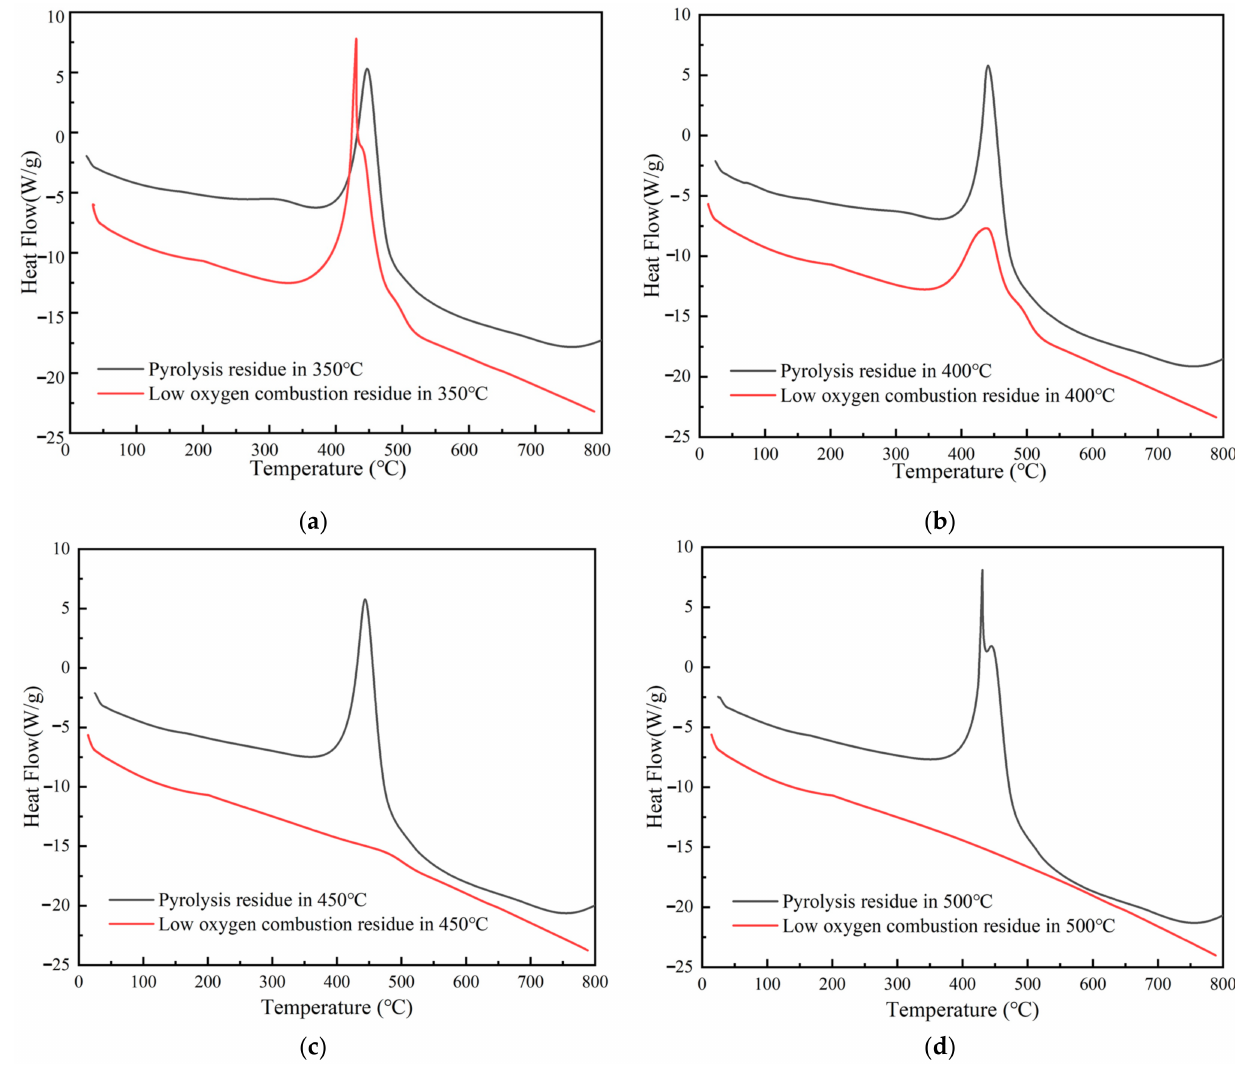
Figure 10. The DSC curve of residues’ oxidation. ( a ) The constant temperature is 350 ◦ C, ( b ) the constant temperature is 400 ◦ C, ( c ) the constant temperature is 450 ◦ C, and ( d ) the constant temperature is 500 ◦